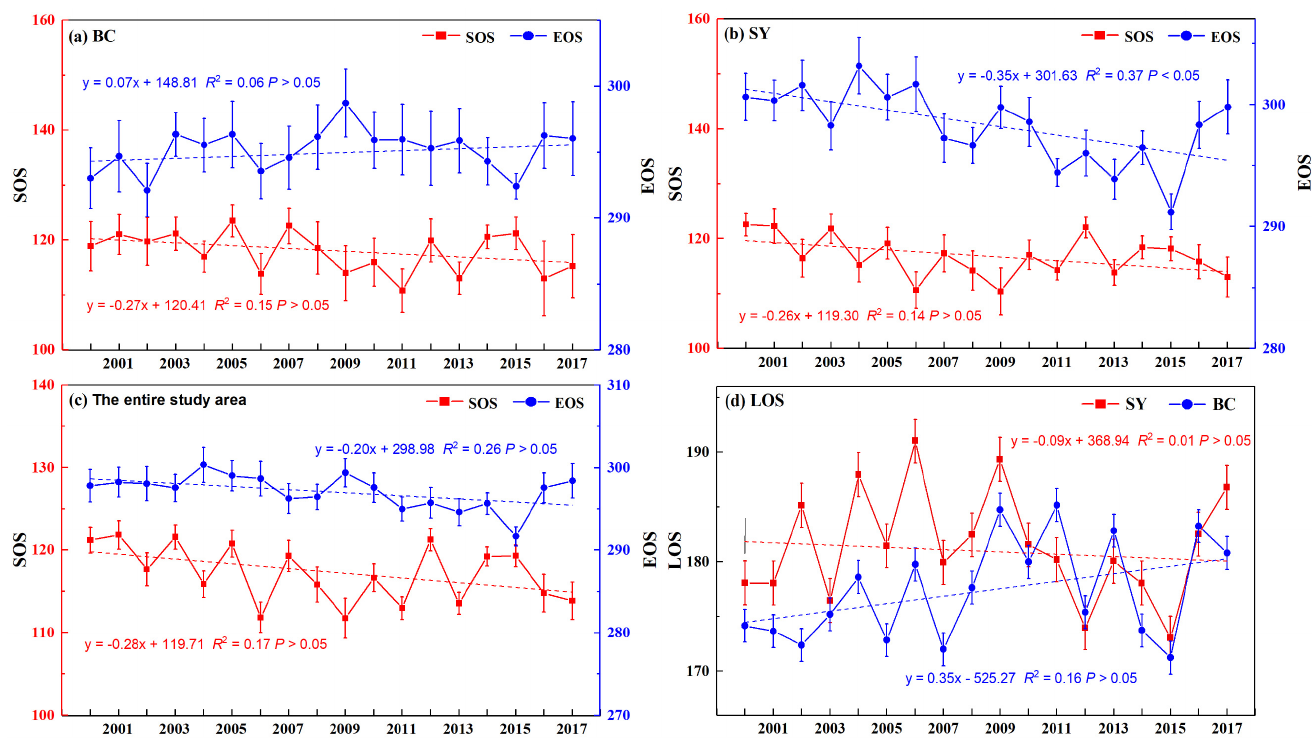
Figure 5. Interannual changes in P. euphratica phenology (SOS, LOS, and EOS) in the upper Tarim River basin from 2000–2017. ( a ) Bachu region (BC), ( b ) Shaya region (SY), ( c ) entire study area, ( d ) LOS of BC and SY.